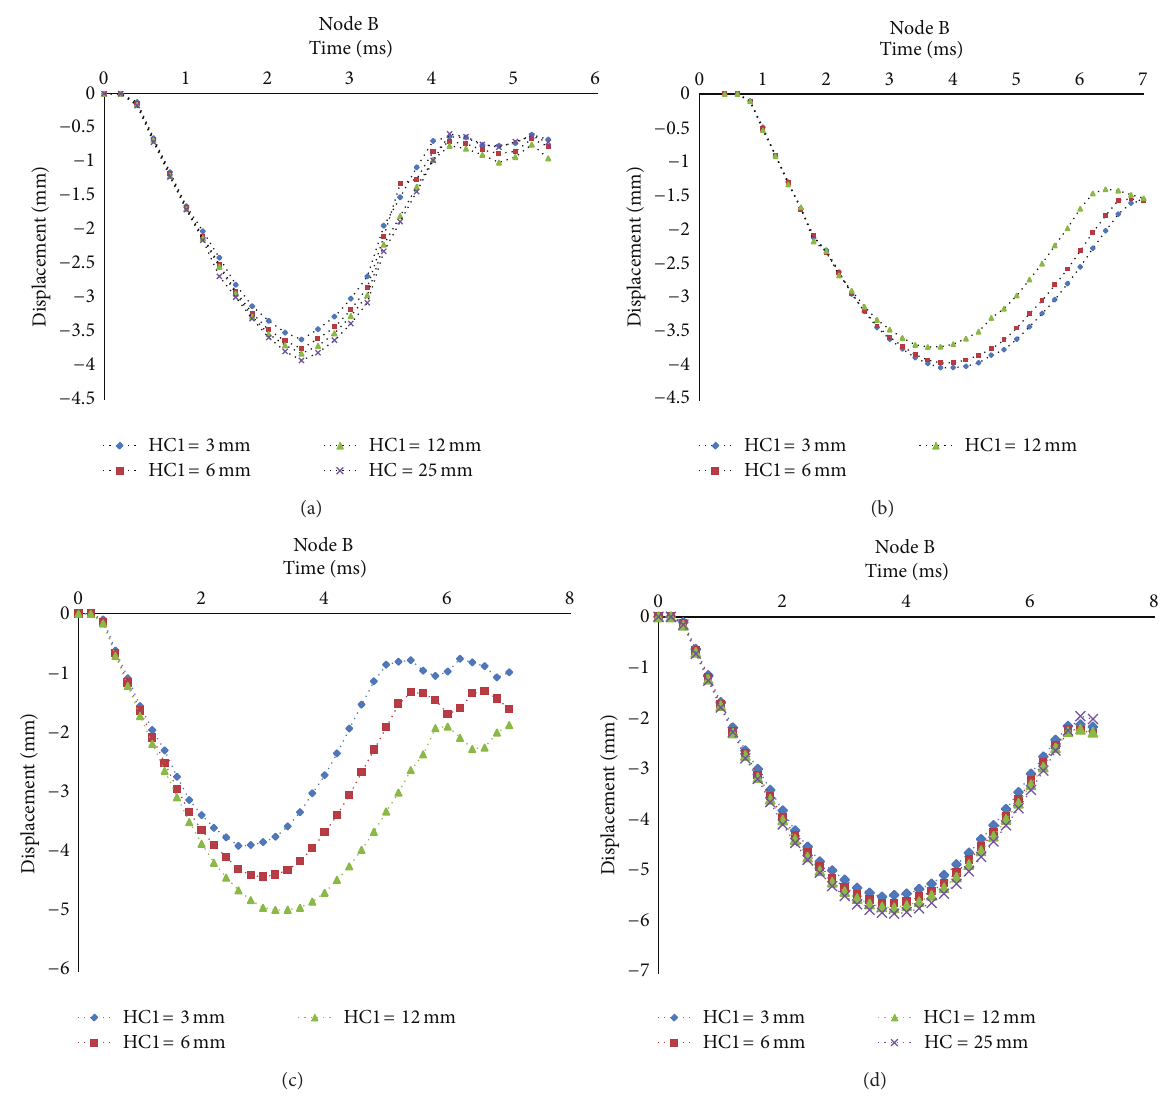
Figure 6: Local displacement at Node B in different locations of internal sheet: (a) Case 1: EPP-EPP; (b) Case 2: EPP-PUR; (c) Case 3: PUR- EPP; (d) Case 4: